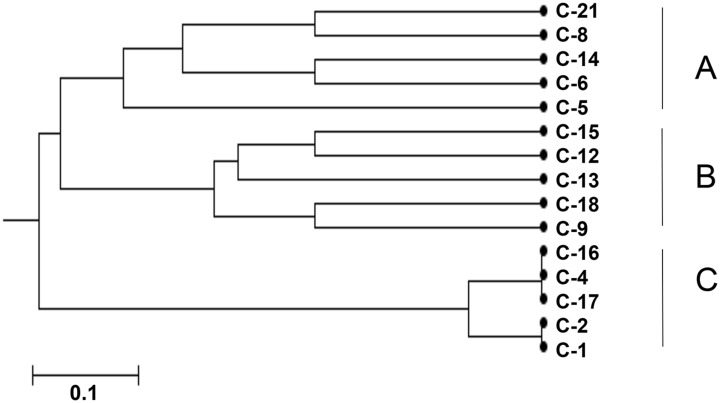
Dendrogram of genetic relationship between 15 C. albicans isolates from the S-ECC children saliva sample, based on the seven housekeeping loci.*The dendrogram was constructed by using the unweighed pair-group method. The linkage distance is indicated at the bottom.